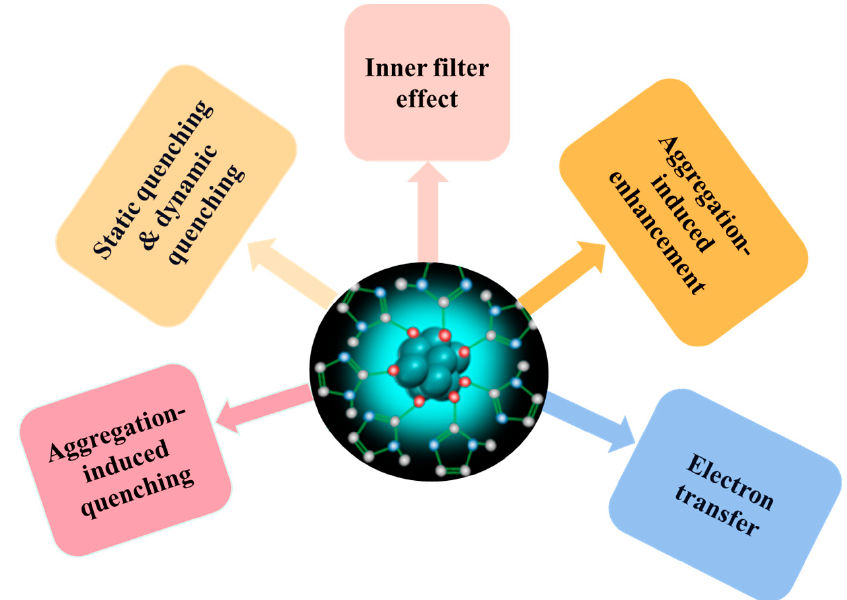
Figure 7. Common mechanisms of fluorescent sensors .